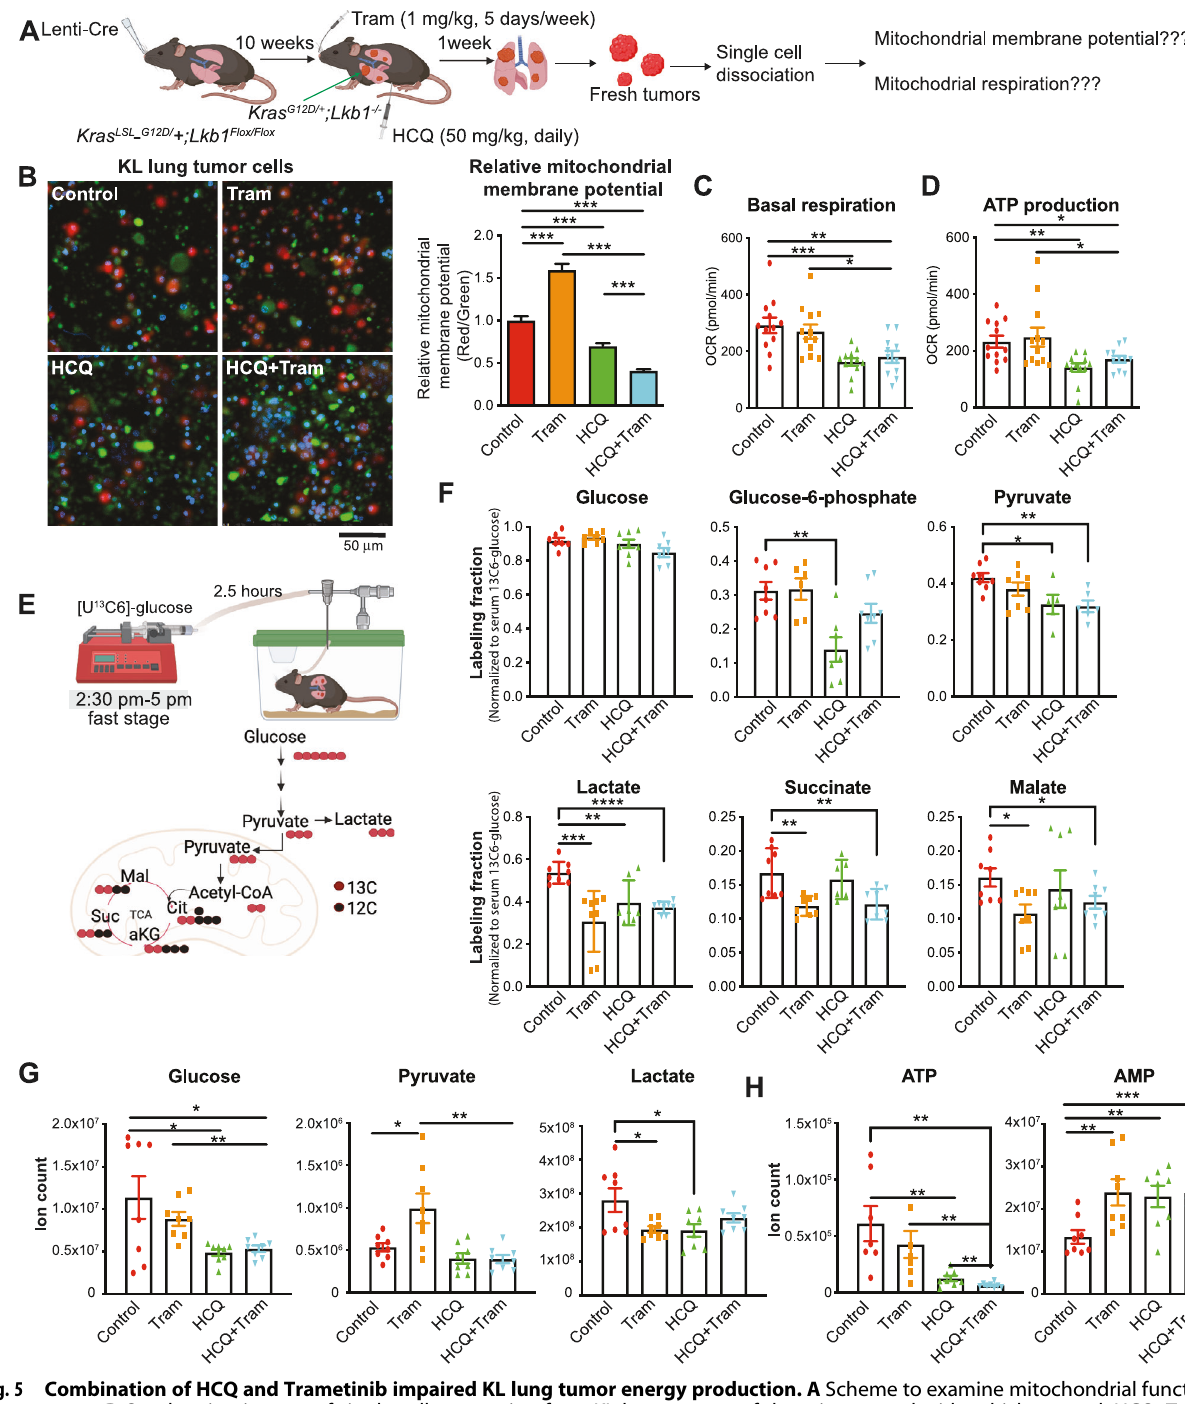
Fig. 5 Combination of HCQ and Trametinib impaired KL lung tumor energy production. A Scheme to examine mitochondrial function in KL lung tumors. B Overlapping images of single-cell suspension from KL lung tumors of the mice treated with vehicle control, HCQ, Trametinib, or the combination for one week and stained with MitoTracker Red CMXRos for mitochondrial membrane potential and Mitotracker Green FM for mitochondrial mass (left panel); and graph of the relative mitochondrial membrane potential of single-cell suspension from KL lung tumors (the ratio of red fl uorescence intensity and green fl uorescence intensity) (right panel). Blue: Hoechst 33342 for nuclear staining. C Basal mitochondrial respiration of single-cell suspension from KL lung tumors of the mice treated with vehicle control, HCQ, Trametinib, or the combination for one week, measured by Seahorse XFe24 Analyzer. D ATP production of single-cell suspension from KL lung tumors of the mice treated with vehicle control, HCQ, Trametinib, or the combination for one week, measured by Seahorse XFe24 Analyzer. E Scheme of in vivo [U 13 C6]-glucose tracing in mice treated with vehicle control, HCQ, Trametinib, or the combination for two weeks (top panel) and 13 C glucose carbons to glycolytic and TCA cycle intermediates (bottom panel). F Normalized labeling fraction of glucose and TCA cycle intermediates of KL lung tumors by infused [U 13 C6]-glucose in mice for 2.5 h. G Levels of glucose, pyruvate, and lactate of KL lung tumors from mice treated with vehicle control, HCQ, Trametinib, or the combination for two weeks. H Levels of ATP and AMP of KL lung tumors from mice treated with vehicle control, HCQ, Trametinib or the combination for two weeks. Data are mean ± s.e.m. * P < 0.05; ** P < 0.01; *** P < 0.001; **** P <